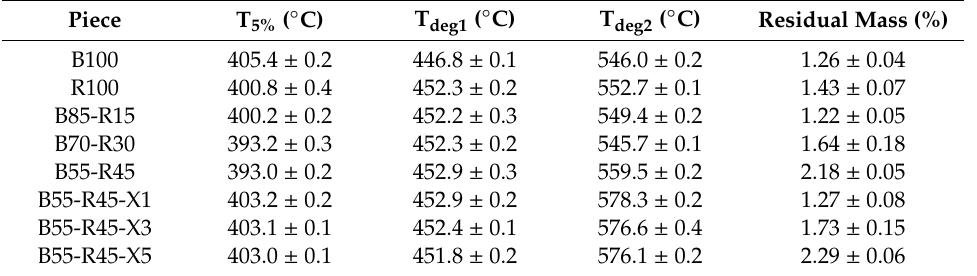
Table 5. Summary of the main thermal properties of the injection-molded pieces of the partially bio-based and recycled polyethylene terephthalate (bio-PET / r-PET) blends in terms of the degradation temperature at 5% of mass loss (T 5% ), degradation temperature (T deg ), and residual mass at 700 ◦